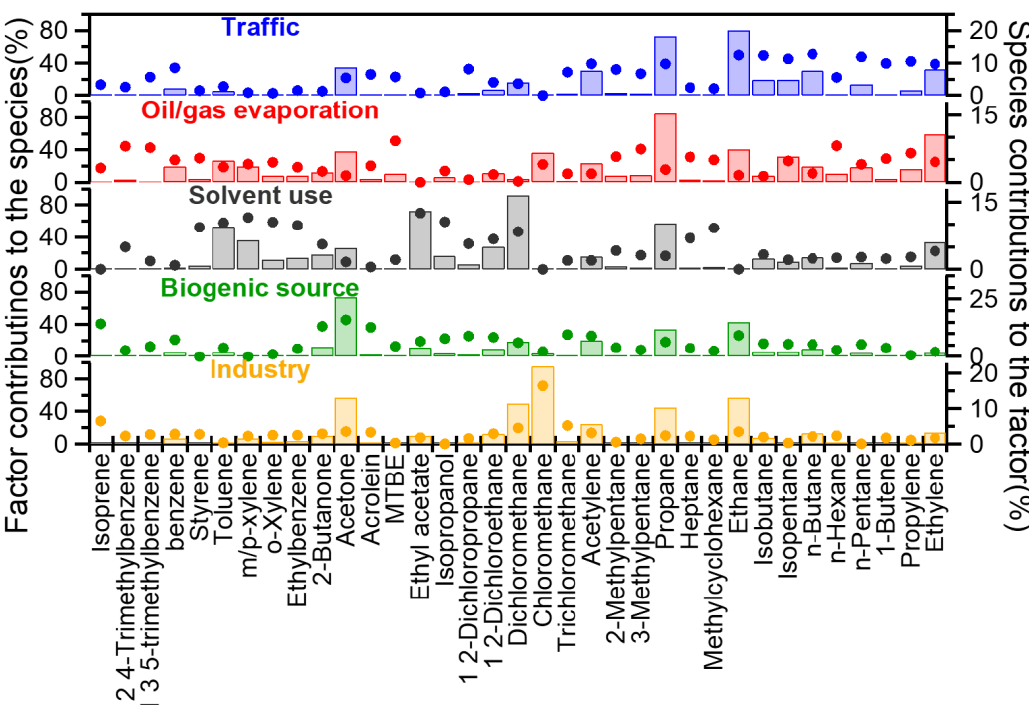
Figure 7. Mass profiles of the five PMF-resolved factors (solid dots refer to the factor contributions to each species; bars represent the mass contributions of each species to the factors).